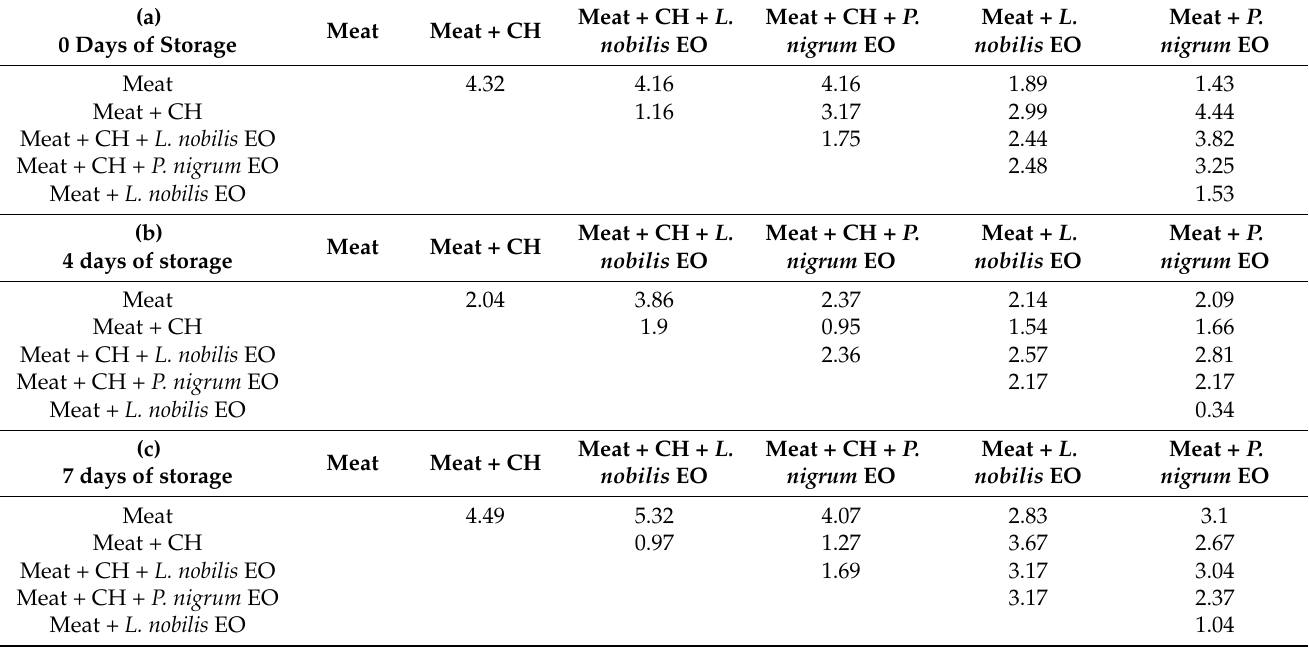
Table 5. CIE L*a*b* color differences ( ∆ E ∗ ab ) among